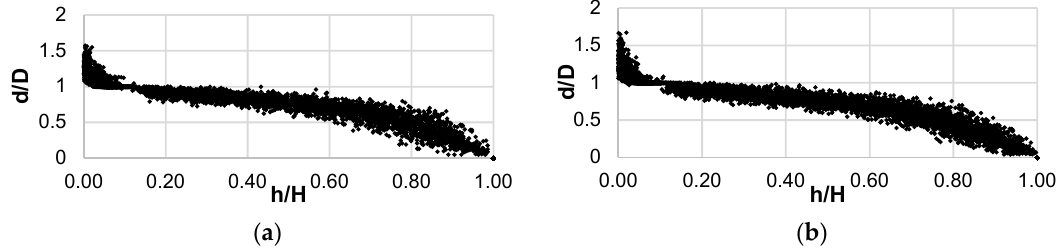
Figure 1. Scatter plots of relative diameter ( d / D ) against relative height ( h / H ) for the Pinus cooperi trees ( a ) and for the Pinus durangensis trees ( b ) under study. Table 1. Summary statistics of the data on the tree species under